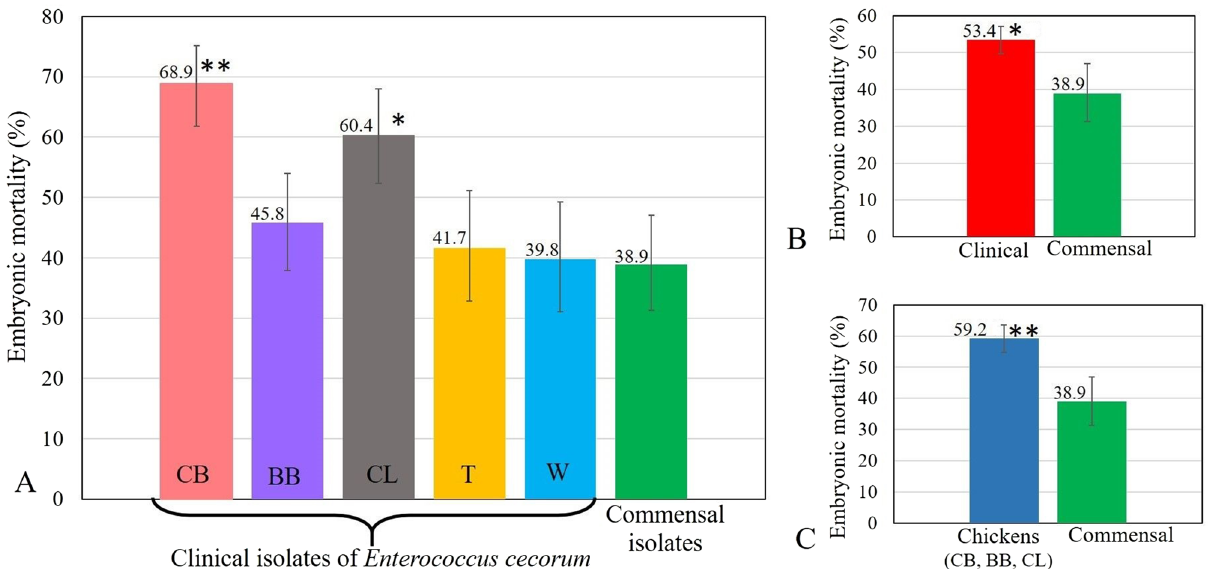
Figure 1. Cumulative embryo mortality rate (%) following infection with all doses of (A) clinical CB (n = 5), BB (n = 4), CL (n = 4), T (n = 3), W (n = 3) and commensal (n = 4) Enterococcus cecorum strains (B) all clinical (n = 19) and commensal (n = 4) E. cecorum strains (C) all clinical chicken isolates (n = 13; CB, BB, CL) and commensal E. cecorum . ** p < 0.001, * p <